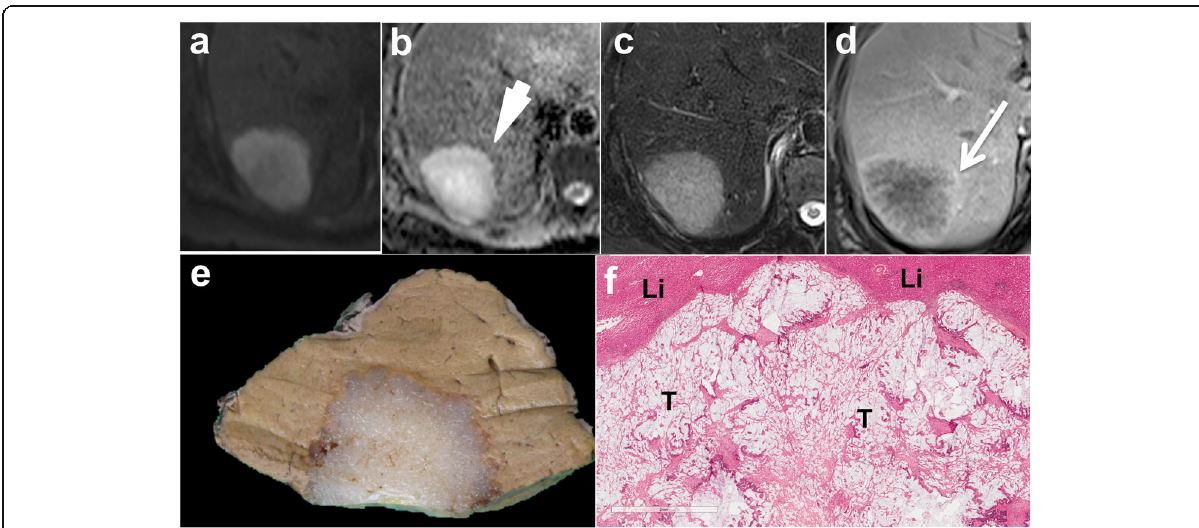
Fig. 7 Mucinous liver metastasis in a 53-year-old male. The 60 mm mucinous lesion located in the right liver lobe shows high signal intensity on diffusion weighted image ( b 600 s/mm 2 ) ( a ) with high apparent diffusion coefficient values ( b ) and high signal intensity on fat-saturated fast spin echo T2-weighted image ( c ). There is mild peripheral (arrow) and inner enhancement on extracellular gadolinium chelate-enhanced fat-saturated gradient recall echo (GRE) T1-weighted image obtained during the portal venous phase ( d ). Note the thin layer of low apparent diffusion coefficient values at the periphery of the tumor ( b — arrowhead), corresponding to the enhancing areas. Gross pathology ( e ) and histological analysis ( f ) confirmed the mucinous subtype. Note the pools of extracellular mucin within the tumor (T) well-separated from the rest of the liver parenchyma (Li), which is displaced